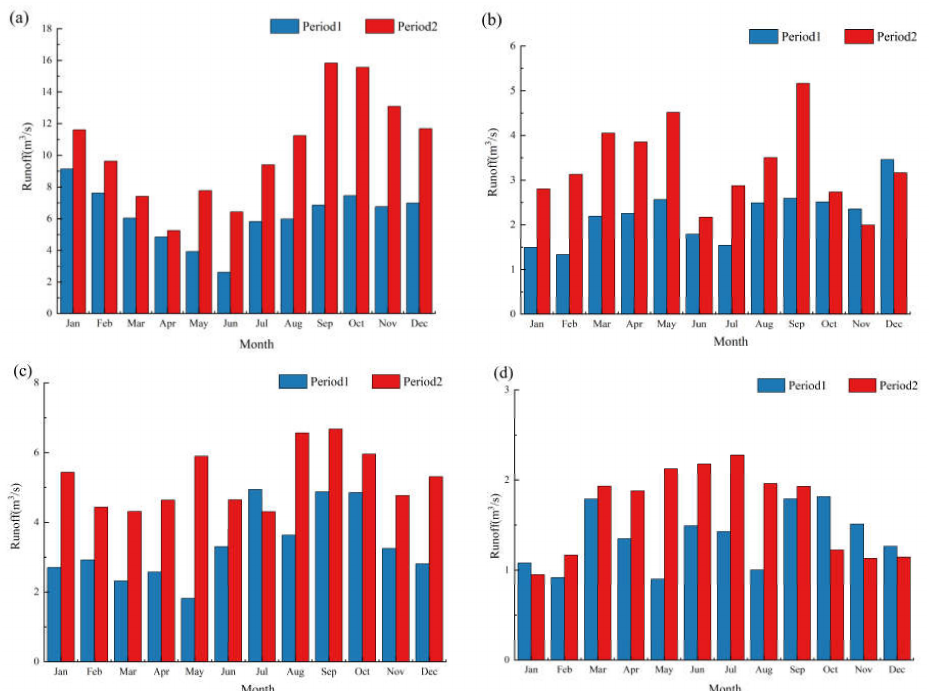
Figure 7. Changes in average monthly diversions for two periods in the four canals. ( a ). Dayuefeng canal; ( b ). Xiaoyuefeng canal; ( c ). Hongqi canal; ( d ). Yuejin canal. From the geographical location and irrigation area of the four canals in the Zhanghe River Basin, the Dayuefeng and Xiaoyuefeng canals mainly provide irrigation water for Hebei Province, while the Yuejin and Hongqi canals mainly provide irrigation water for Henan Province. Moreover, from the change of interannual water diversions in the two periods, the proportion of water used in Hebei Province increased from 36.48% to 47.67%, the proportion of water used in Henan Province increased from 19.37% to 23.07% and the remaining water resources in Shanxi Province decreased from 44.14% to 29.26% (Figure 8) Hebei Province’s water demand has risen to twice that of Henan Province.